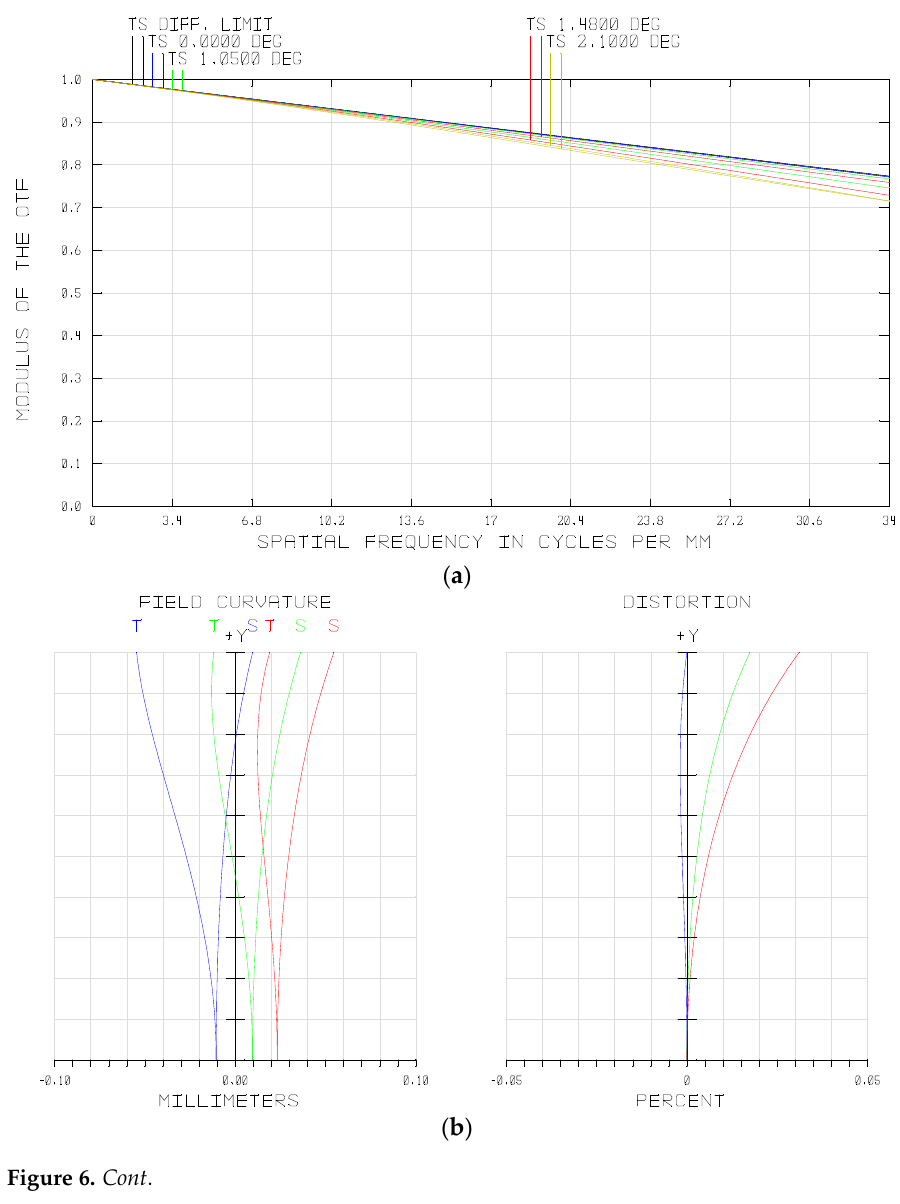
Figure 5. Optical layout of the fore-optics.